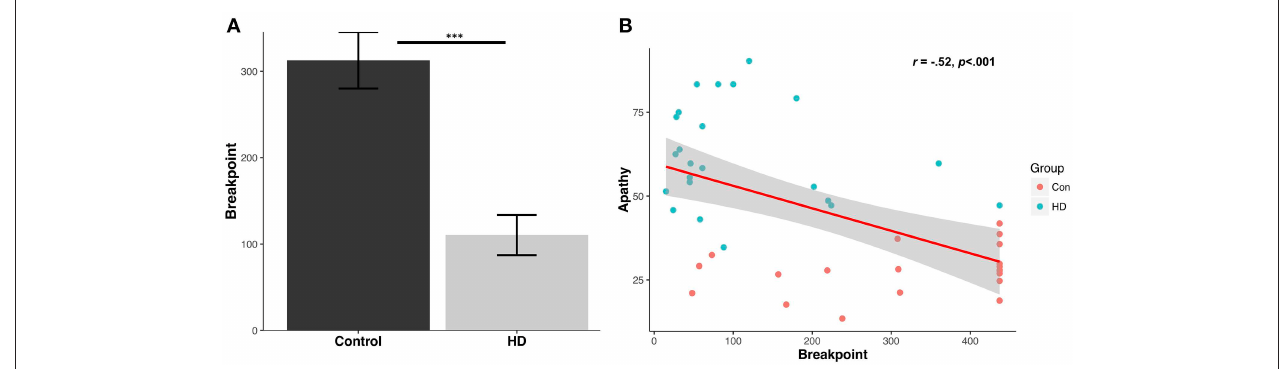
FIGURE 1 | Human progressive ratio breakpoint and correlation with questionnaire apathy scores. (A) Average breakpoint for controls and HD patients; *** p < 0.001. (B) Levels of questionnaire-determined apathy for controls and patients (LARS-e and AES) correlate with progressive ratio breakpoint.